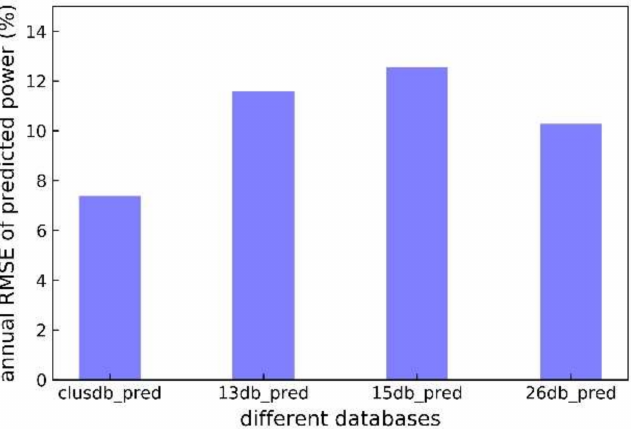
Figure 9. The annual RMSE of wind farm output power predicted by different